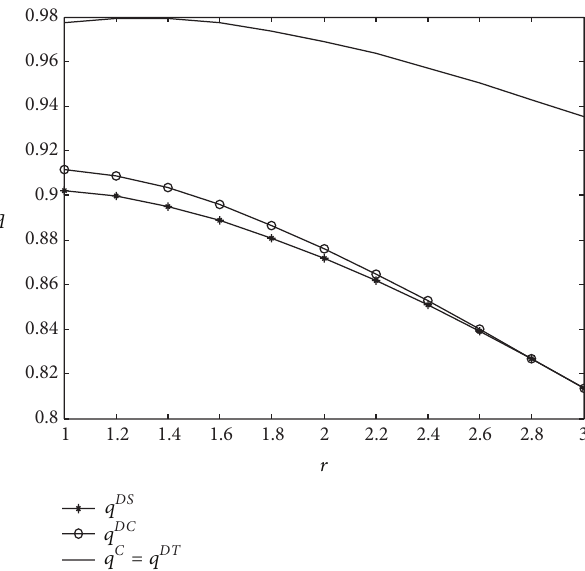
Figure 2: Impact of 𝛾 on optimal emission reduction. Figure 3: Impact of 𝛾 on optimal promotion level.